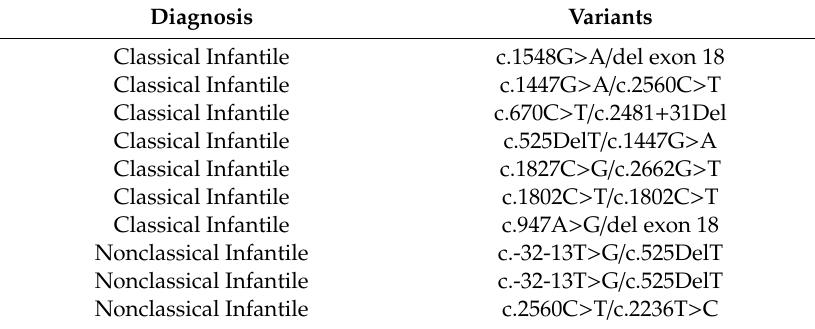
Table 4. Variants Identified in Infantile Pompe Disease Patients through Prospective